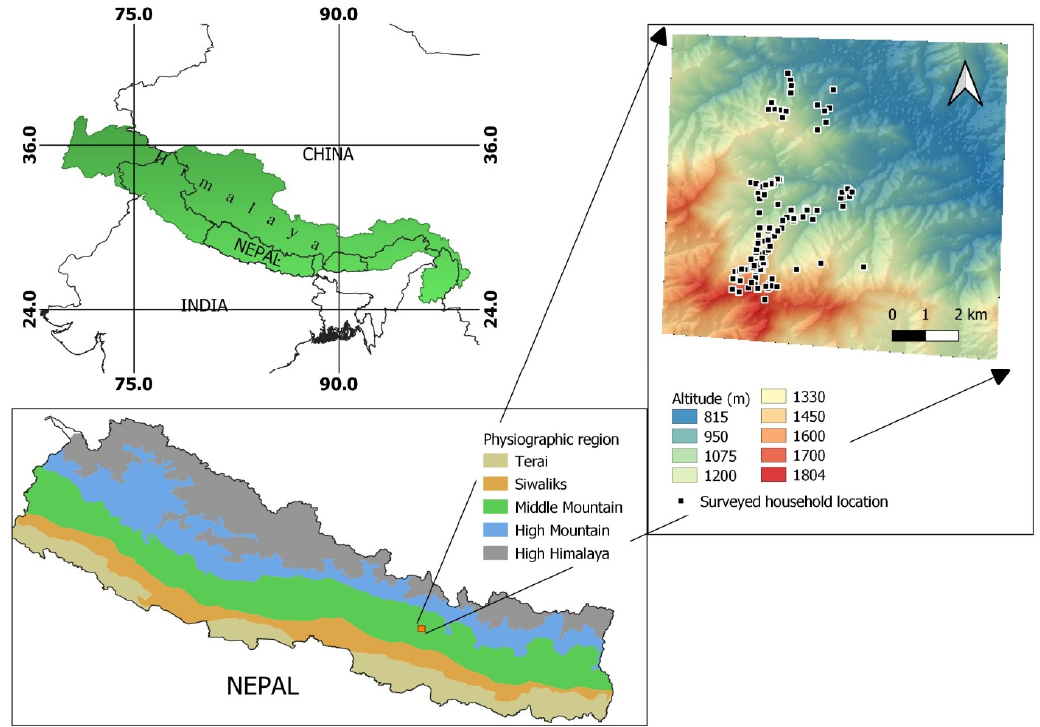
Figure 1. Location map of the study area in the mid-hills of central Himalayas, Nepal.